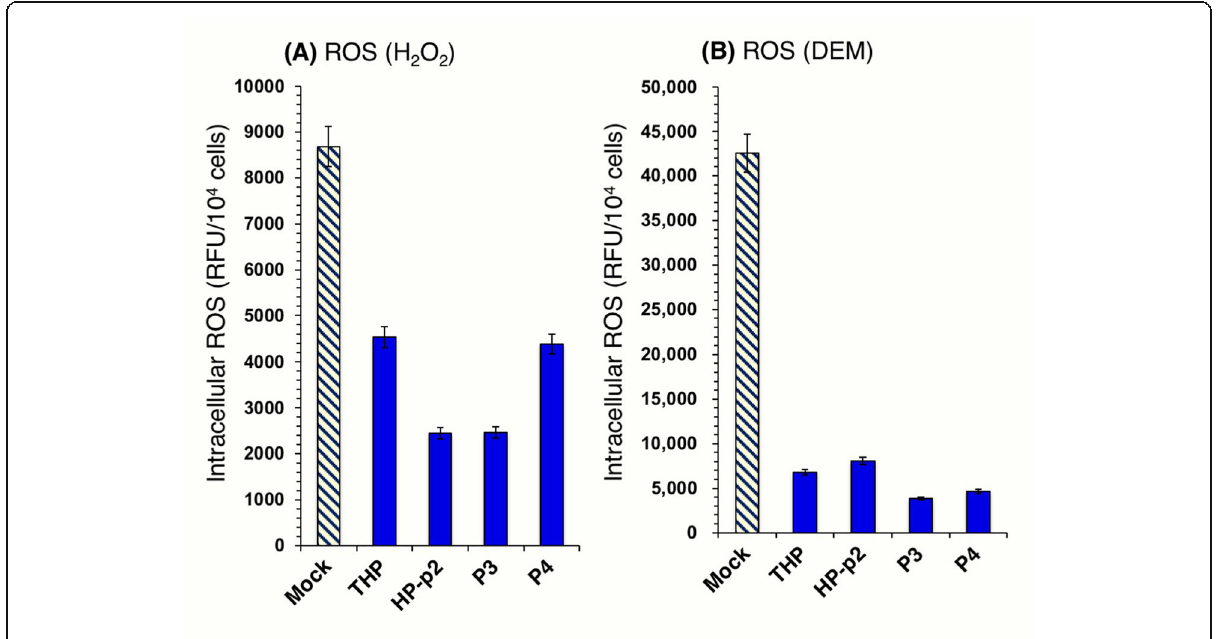
Fig. 4 Intracellular reactive oxygen species (ROS) of HCT-116 cells oxidatively induced with H 2 O 2 or DEM. Cells (10 5 cells/mL) oxidized with H 2 O 2 ( a ) or DEM ( b ) were pre-incubated with THP, HP-p2 or the active peptides peaks (P3 or P4) at concentration of 200 μ g/mL for 1 h at 37 °C under